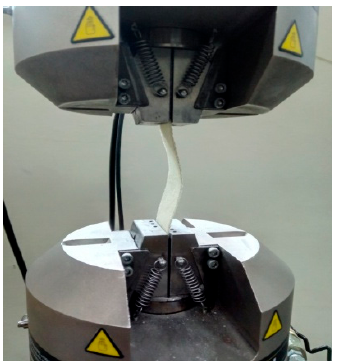
Figure 7. Buckling of a composite sample.